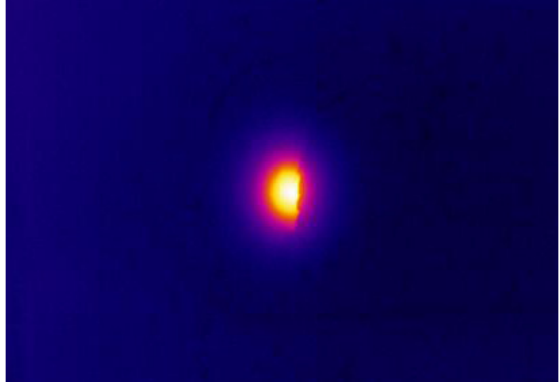
Figure 1. Temperature distribution around a crack, 20 s after laser OFF.